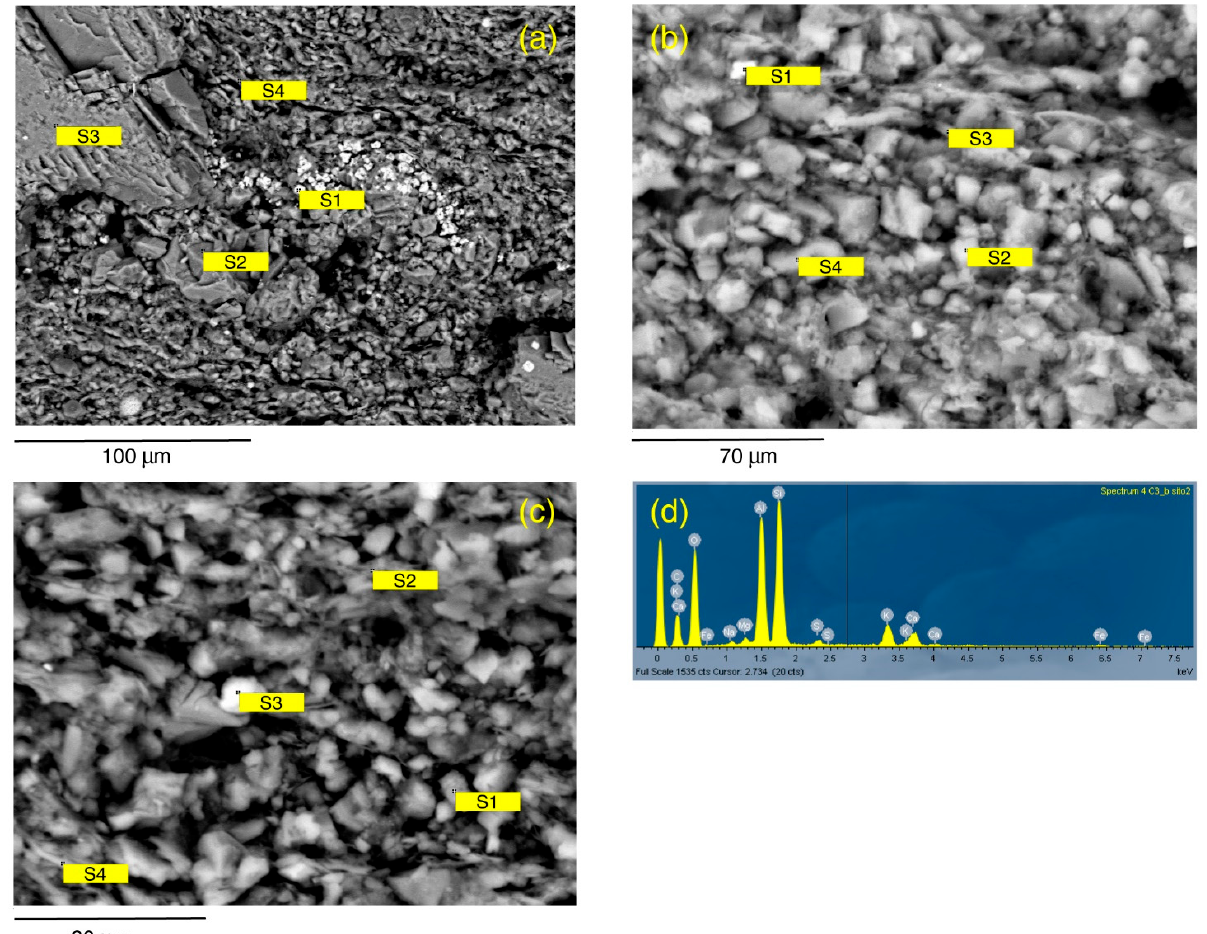
Figure 8. SEM-EDS data of C3 sample in thin section. ( a ) General aspect at low magnification scale